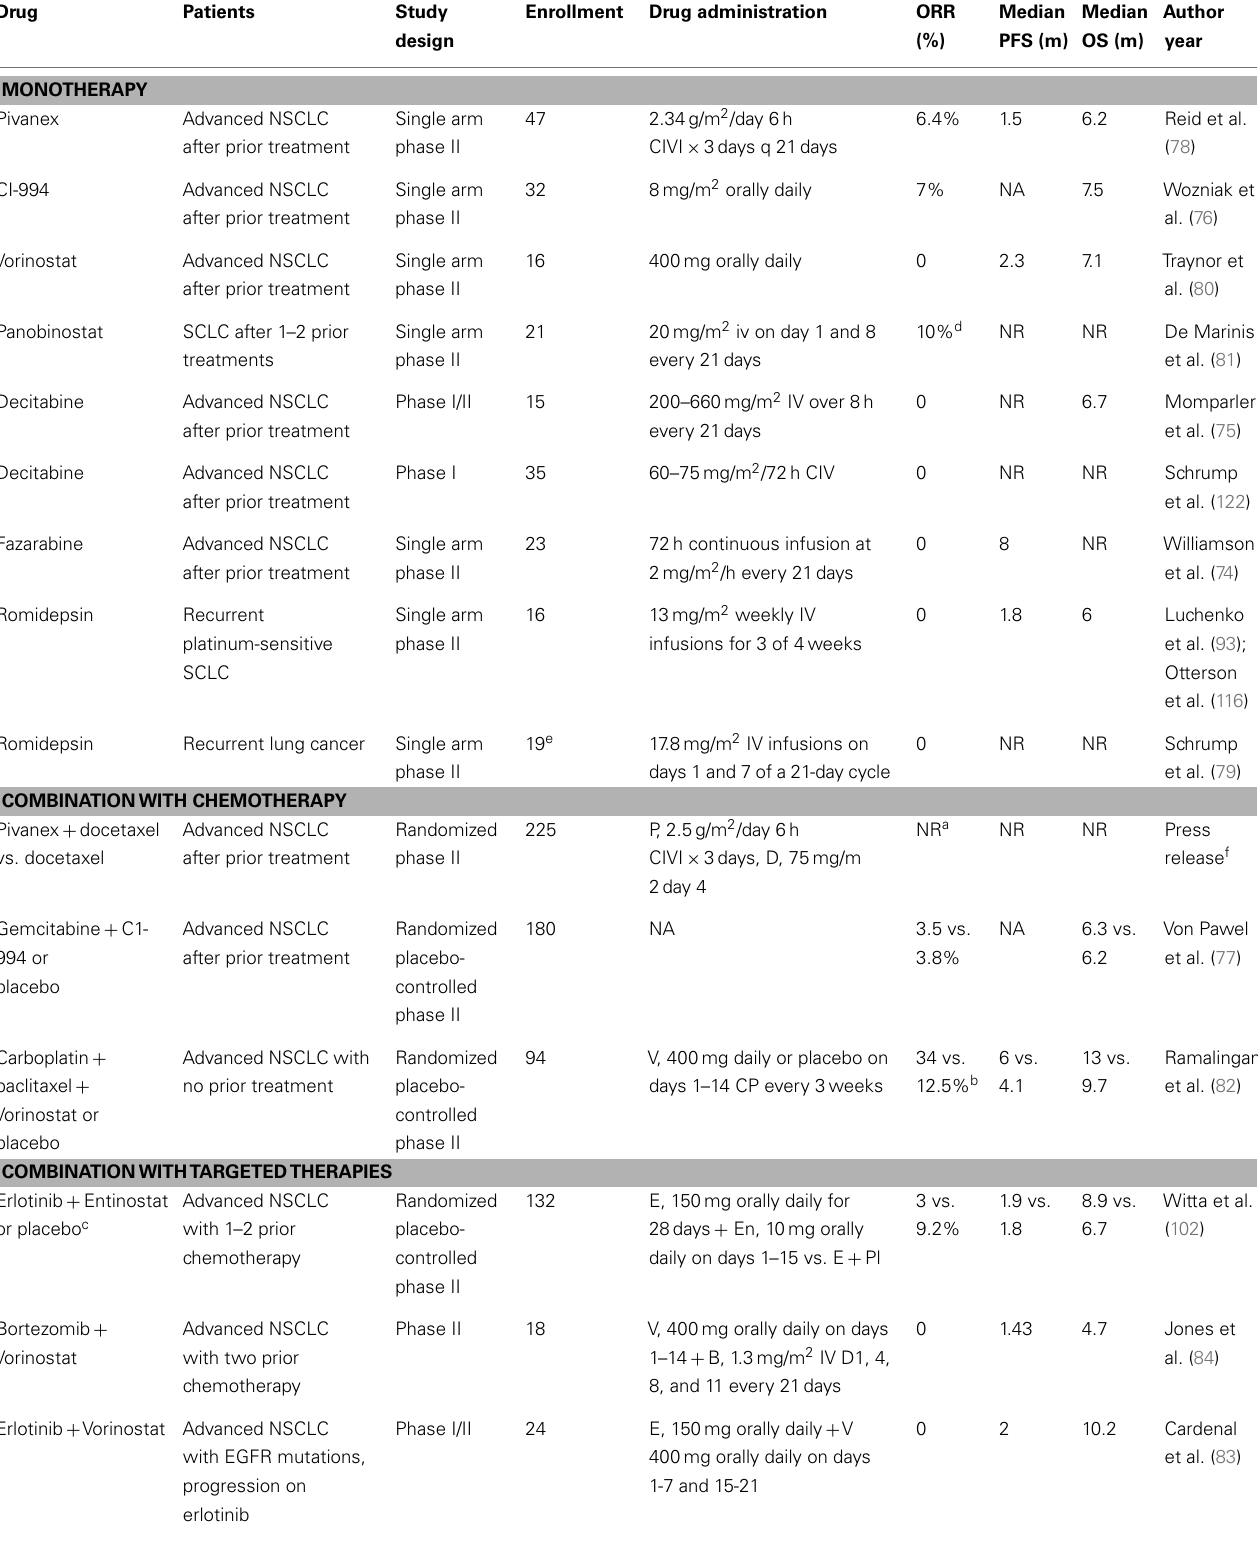
Table 2 | Selected clinical trials of epigenetic therapies in lung